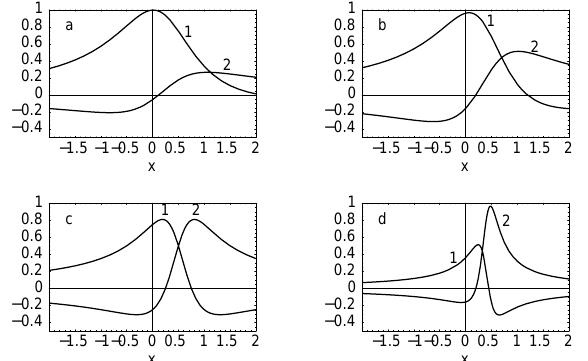
FIG. 1. The functions f k (curve 1) and f (cid:1) (curve 2) versus x : (a) r (cid:1) 0.25 , (b) r (cid:1) 0.5 , (c) r (cid:1) 1 , and (d) r (cid:1) 2 .